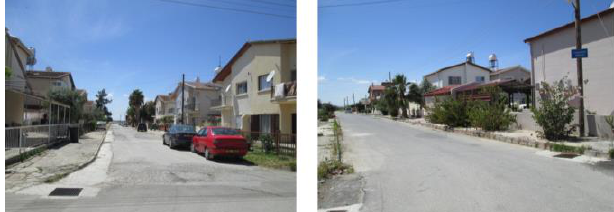
Figure 2. Inadequate greenery and lack of sidewalk, “Turan Kaynak Sitesi” April , 2015 (Photos taken by